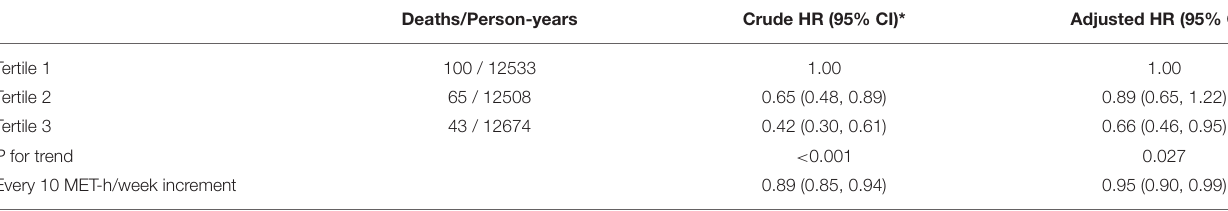
TABLE 2 | Associations of all-cause mortality with habitual physical activity.